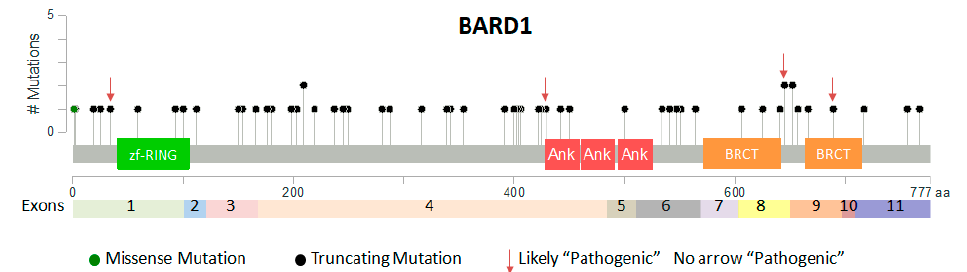
Figure 2. BARD1 germline coding mutations. The protein domains RING (green), Ankyrin (ANK, red), BRCA1 carboxy-terminal (BRCT, orange) are indicated. Coding mutations of BARD1 defined as “Pathogenic” and “Likely Pathogenic” in ClinVar database (https://www.ncbi.nlm.nih.gov/clinvar/) are shown. The red arrows indicate the mutations categorized as “Likely Pathogenic”, the other mutations without the arrow are categorized as